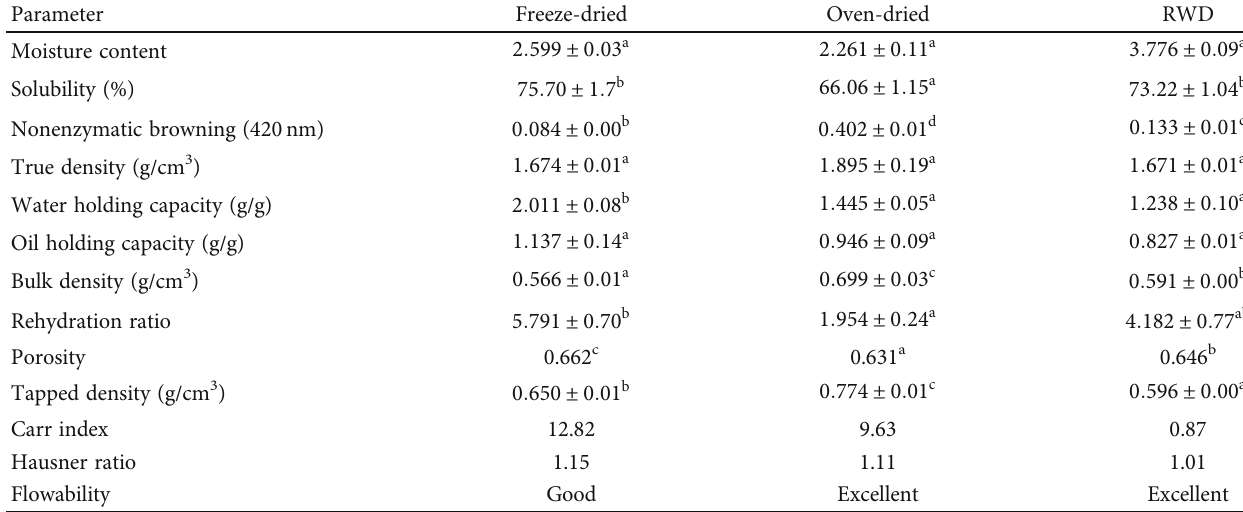
Table 5: Properties of jackfruit powders obtained using di ff erent drying